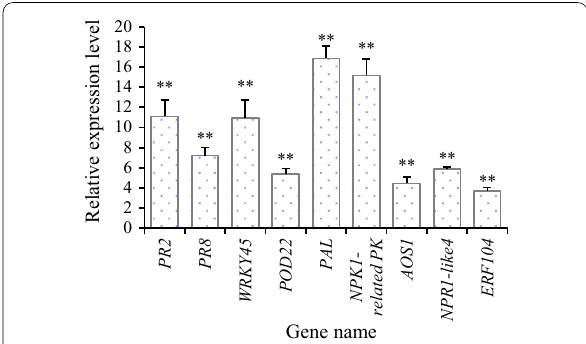
” represents P > 0.05 −